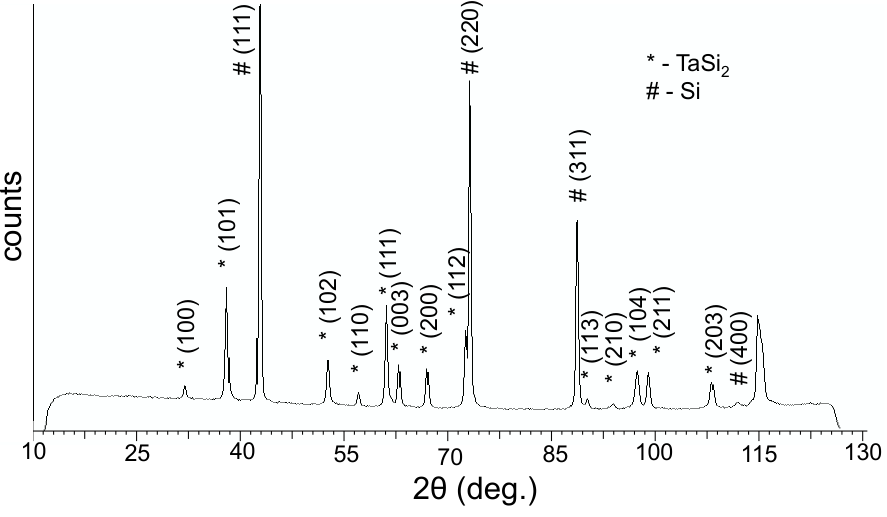
Figure 1. X-ray diffractogram (XRD) of the obtained powder.